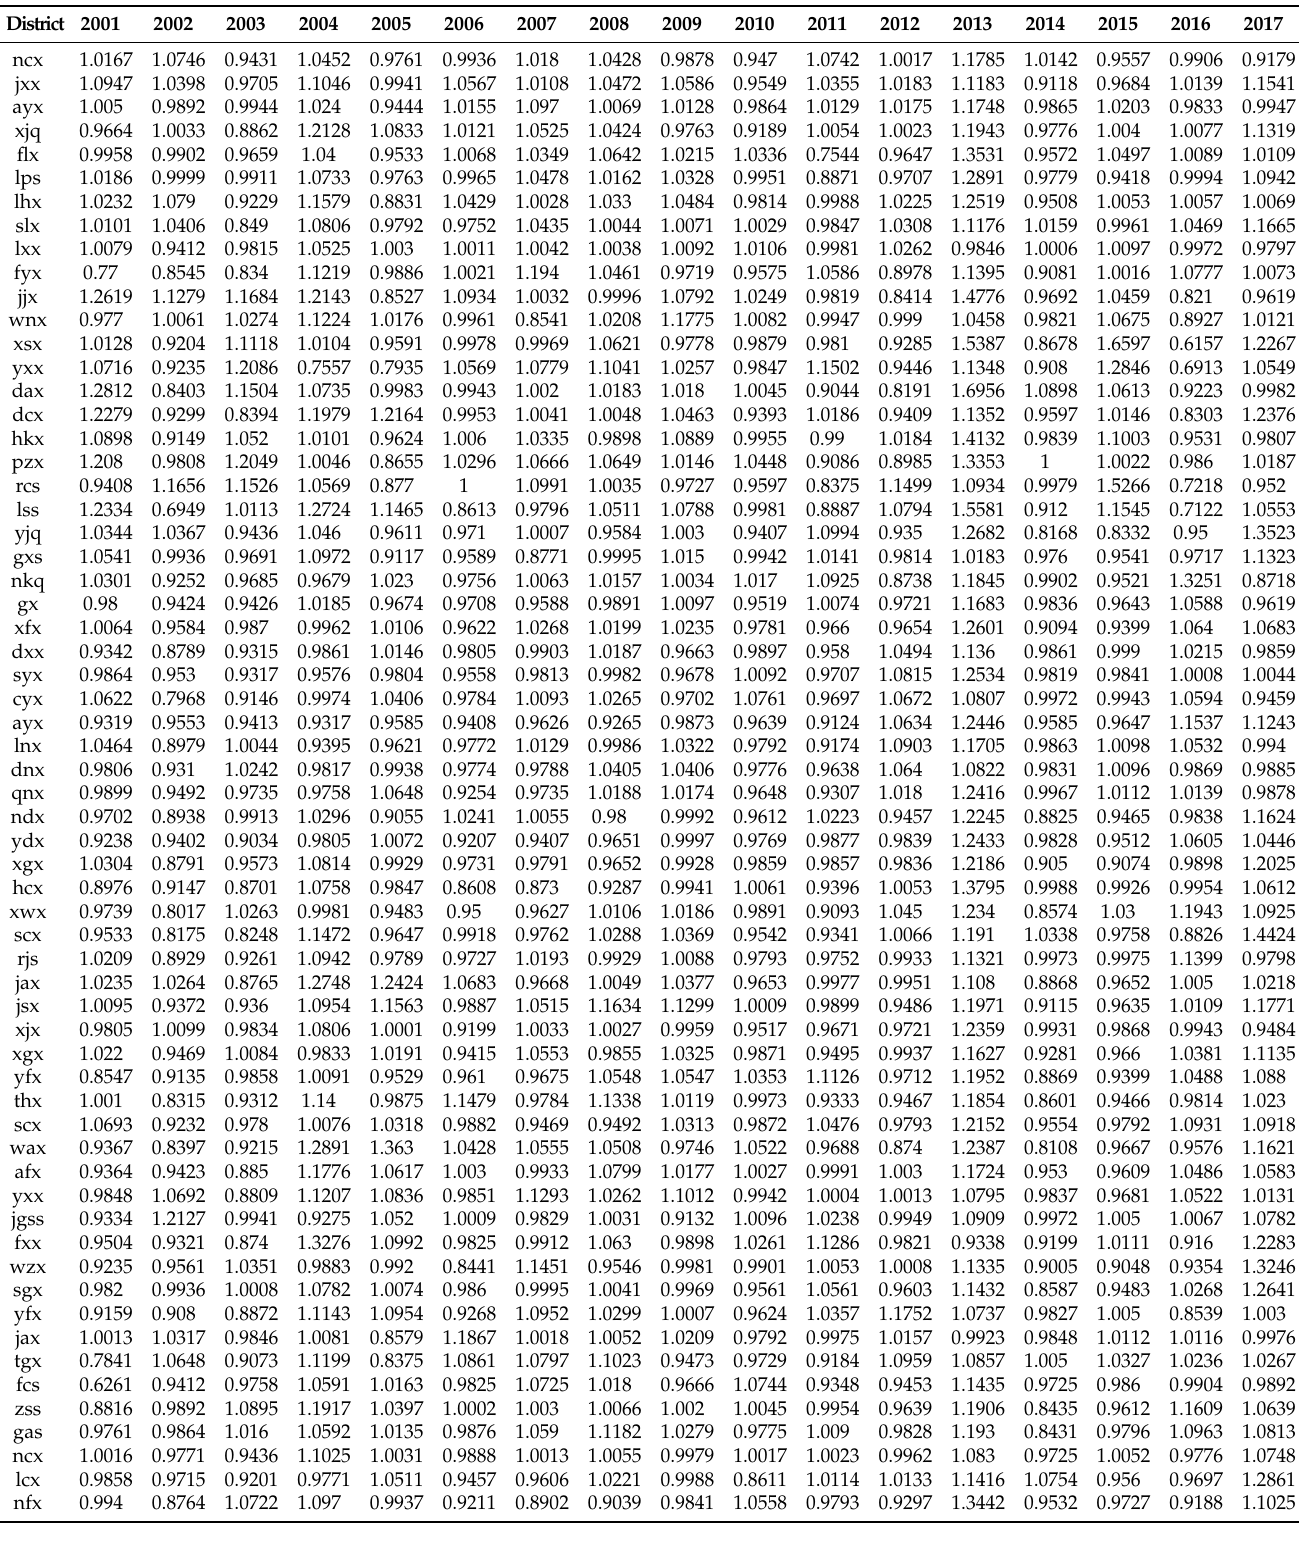
Table A1. GTFP of grain in counties (cities and districts) of Poyang Lake Basin from 2001 to